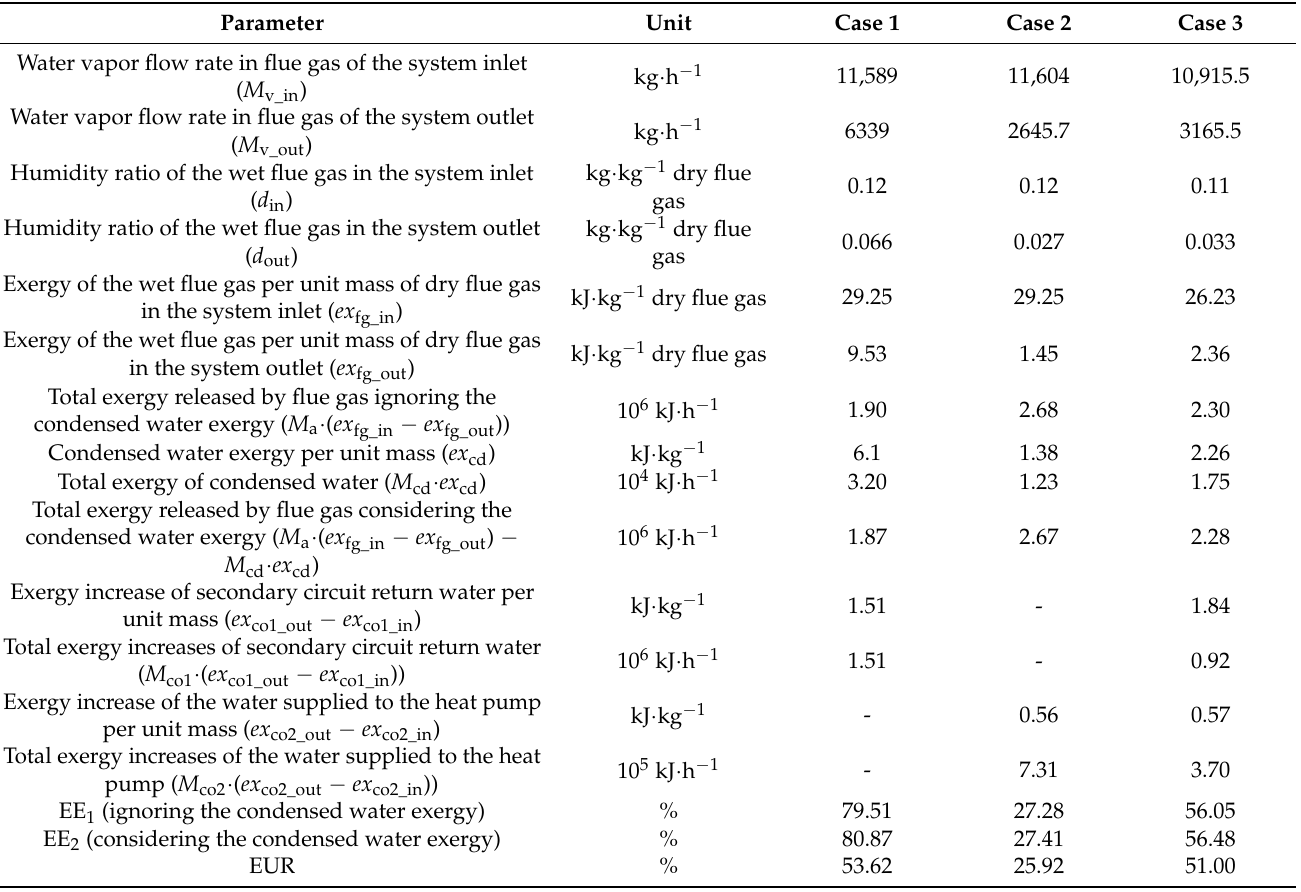
Table 3. Calculation results of exergy